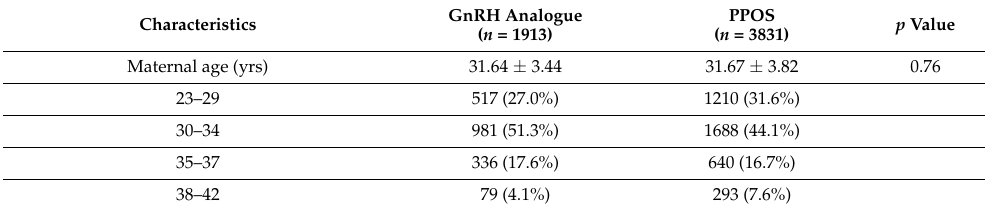
Table 1. The baseline characteristics of the matched data by propensity score.